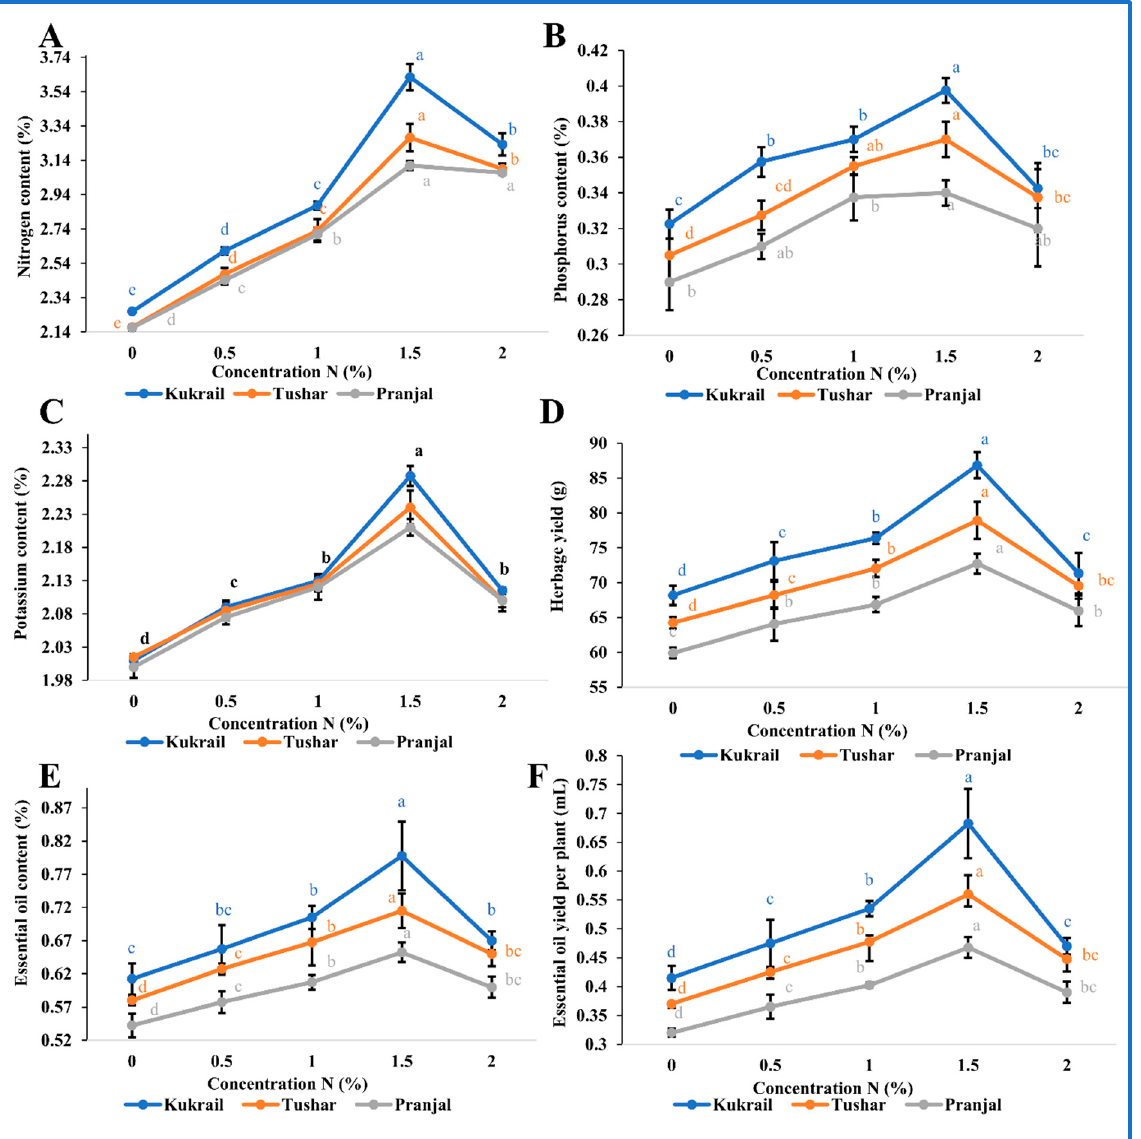
Figure 4. Effect of N on three cultivars: ( A ) Nitrogen (%) of leaves ( B ) Phosphorus (%) of leaves ( C ) Potassium (%) of leaves ( D ) Herbage yield ( E ) Essential oil content ( F ) Essential oil yield per plant of the three peppermint cultivars. Lines represent the mean and bars represent the standard error (SE) of four replicates (n = 4) of each cultivar. The letters represent significance at p ≤ 0.05 by Duncan’s Multiple Range Test (DMRT).